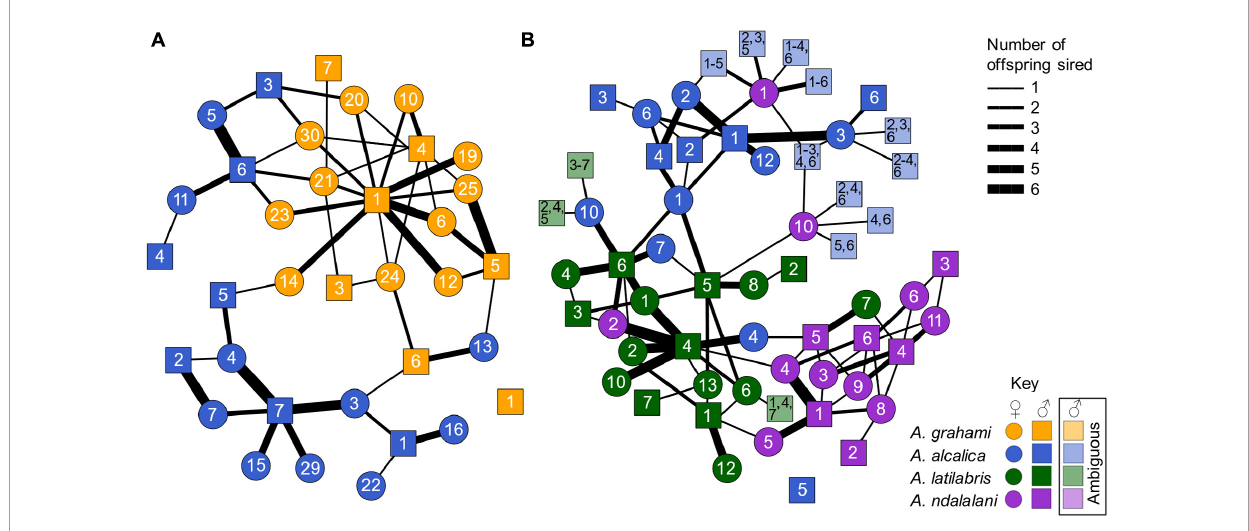
FIGURE4 Network showing parent-offspring relationships in the allopatric experiment (A) and sympatric experiment (B) using offspring paternity data. Colors indicate species: blue = A. alcalica , orange = A. grahami , green = A. latilabris , purple = A. ndalalani . Circles = females and squares = males. Numbers correspond to unique male or female ID. Line thickness denotes the number of offspring sired between parents. Lighter colors denote offspring with ambiguous paternity that were not assigned to a single compatible male. Paternity could be assigned unambiguously in 94.0% of offspring. 88.6% (two-way choice) and 71.0% (three-way choice) of offspring in the allopatric and sympatric experiments resulted from conspecific matings. Mating was significantly assortative in both the allopatric ( r = 0.77, p < 0.001) and sympatric ( r = 0.56, p < 0.001) experiments. There were no significant differences in assortativity between both experiments ( t = 2.37, p =